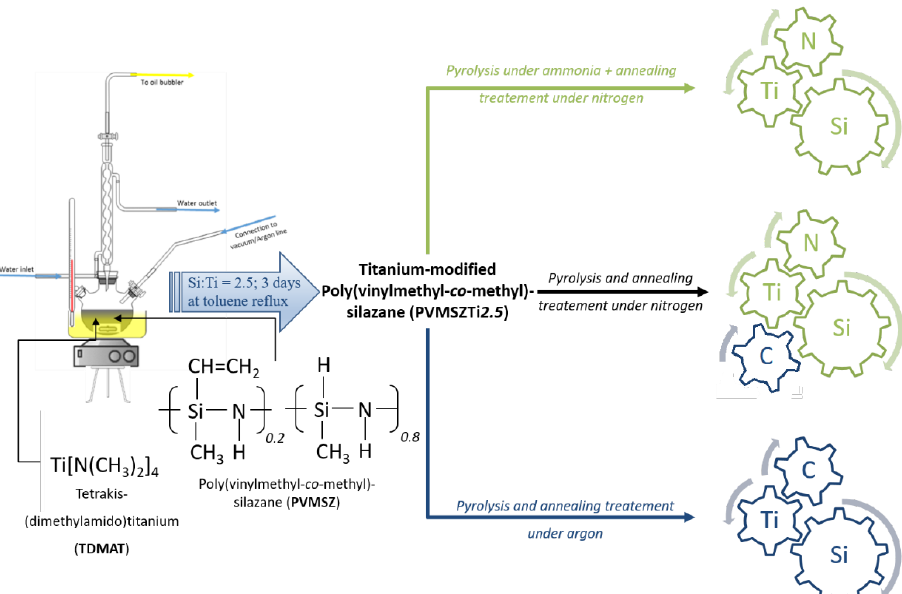
Figure 1. Schematic diagram of the general process of design of nanocomposites in the Si-Ti-N and Si-Ti-C systems from poly(vinylmethyl- co -methyl)silazane.